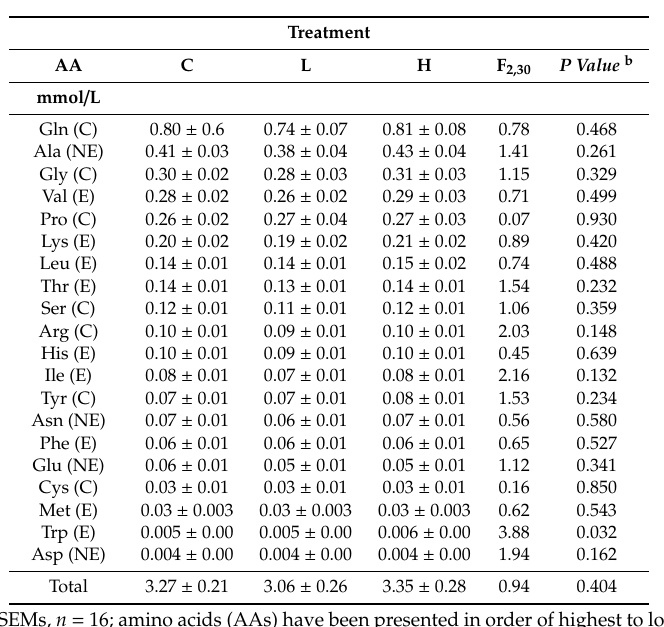
Table 1. Baseline (fasting) plasma amino acid (AA) concentrations prior to consumption of the test drinks consisting of either 0 g (C), 30 g (L) or 70 g (H) of pure whey protein dissolved in varying amounts of distilled water, diet cordial, and sodium chloride (all 450 mL and 88 mOsm / L) a .